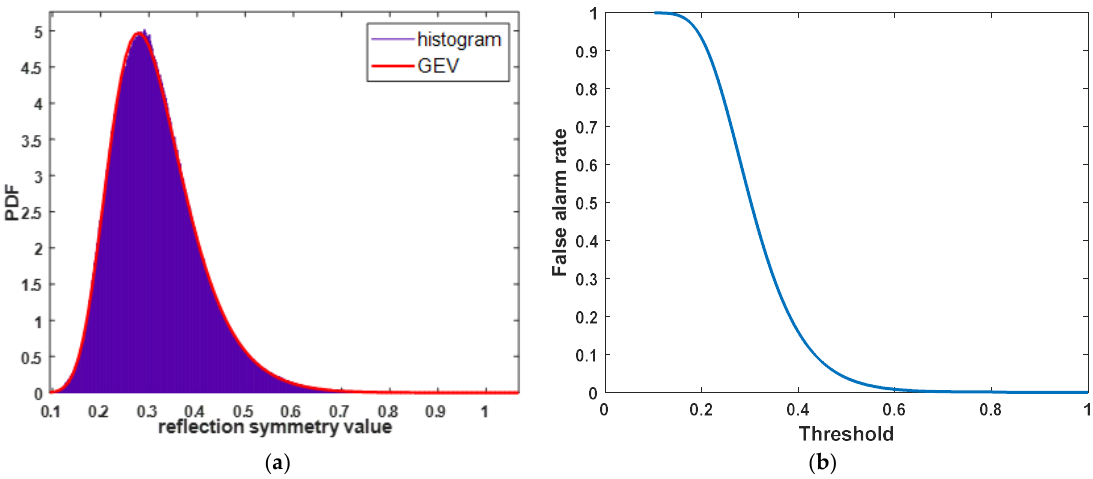
Figure 14. ( a ) Histogram of the reflection symmetry metric of Figure 8c and the fitted GEV distribution curve; ( b ) curve shows the relationship between false alarm rate and threshold.